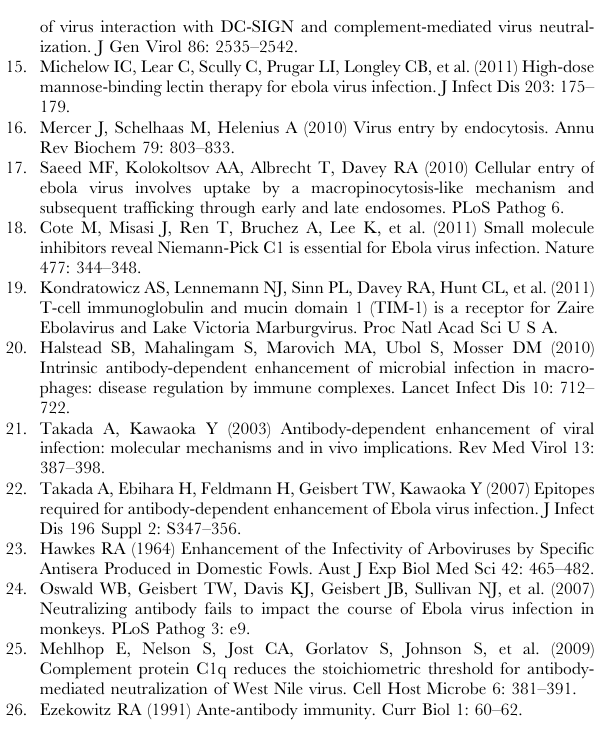
fold in the presence of rhMBL, whereas there was no inhibition of infection in the absence of MBL. Figure S5 MBL-mediated macropinocytosis of HIV- EBOV GP may bypass early endosomes and is dynamin independent. We preincubated HEK293F cells with (A) amiloride hydrochloride, an inhibitor of Na + /H + exchanger activity, (B) bafilomycin A1, a specific and potent inhibitor of vacuolar H + ATPase in early endosomes, (C) monensin, an inhibitor of both endosomal acidification and receptor recycling, and (D) dynasore, a potent and specific dynamin inhibitor (which is involved in clathrin- and caveolin-mediated endocytosis) in 5% MBL-deficient serum in the absence or presence of rhMBL at 37 u C for 1 hour. We then infected cells with HIV-EBOV-GP virion-like particles (1200 pg p24/100 m l). Percentages of infected cells are relative to DMSO controls (a methanol control was used for monensin). Luciferase values were adjusted for cell viability using alamarBlue (resazurin reduction assay). Significant differ- ences are shown. Experiments were performed twice in quadru- plicate. Figure S6 shRNA knockdown of cathepsin-L (CTSL1) and MGL (CLEC10A). We performed RNA interference with a pLK0.1 vector encoding shRNAs that targeted (A) CTSL1 and (B) MGL (CLEC10A) as described for Figure 6. Luciferase values were adjusted for cell viability. Percentage change in infection was normalized to an empty pLK0.1 control vector.